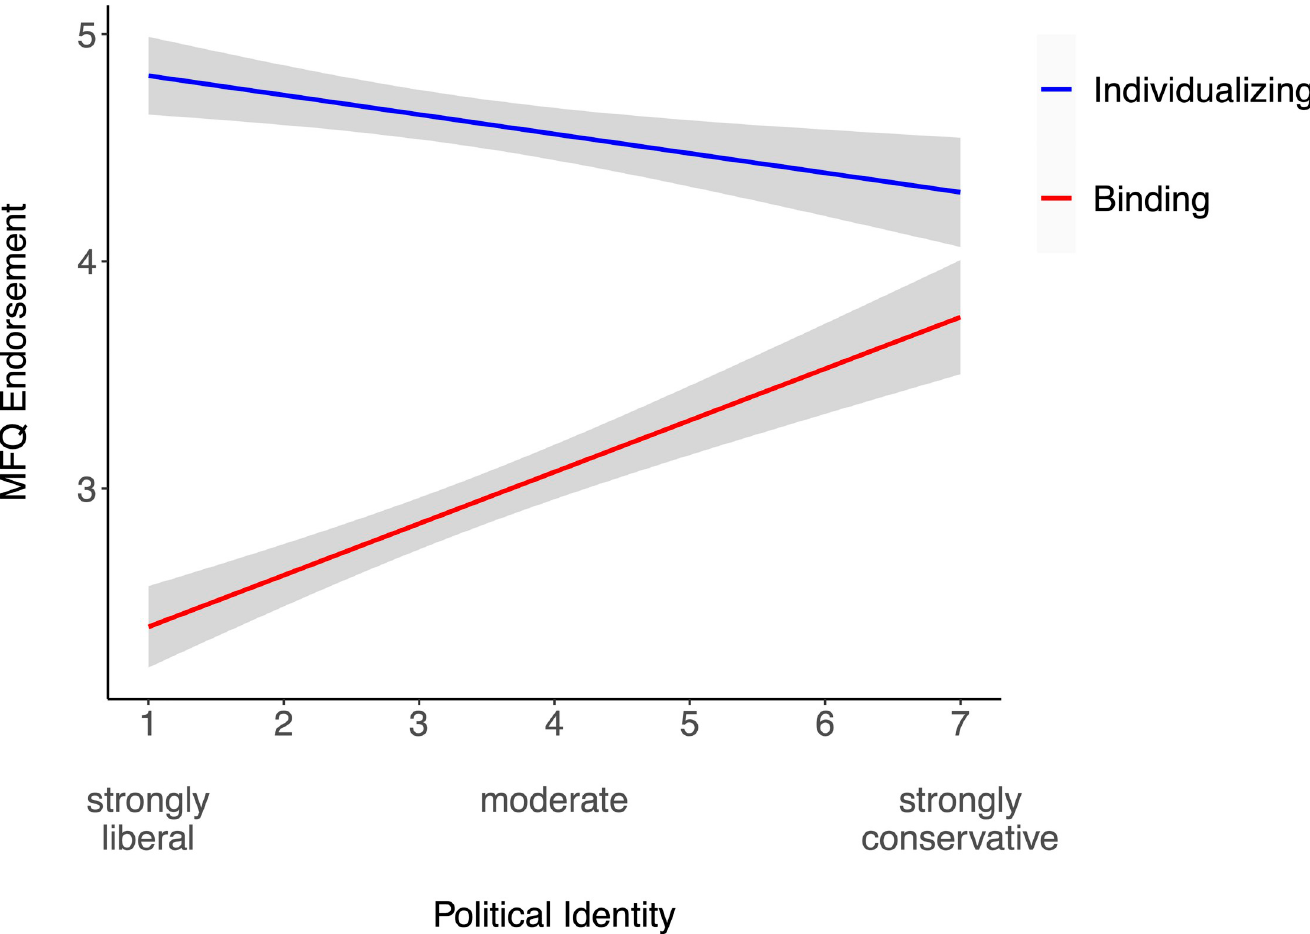
Fig 3. Association between political identity and endorsement of MFQ individualizing and binding moral foundations. The plot depicts the 95% CI around each regression line.